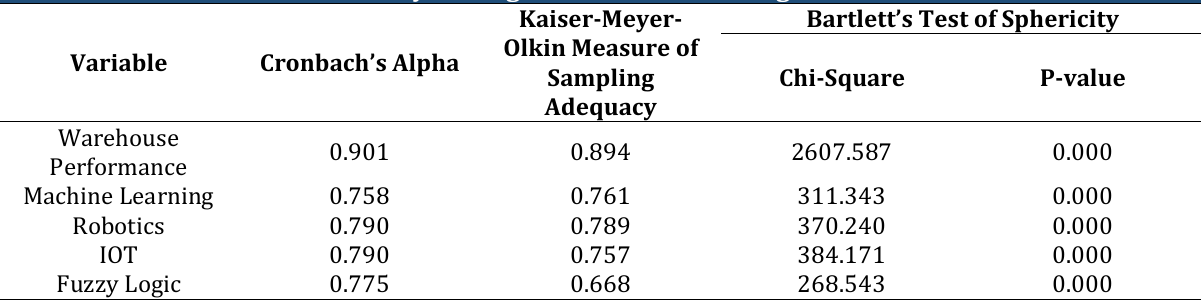
Table 3: Results of data reliability testing and Bartlett’s testing